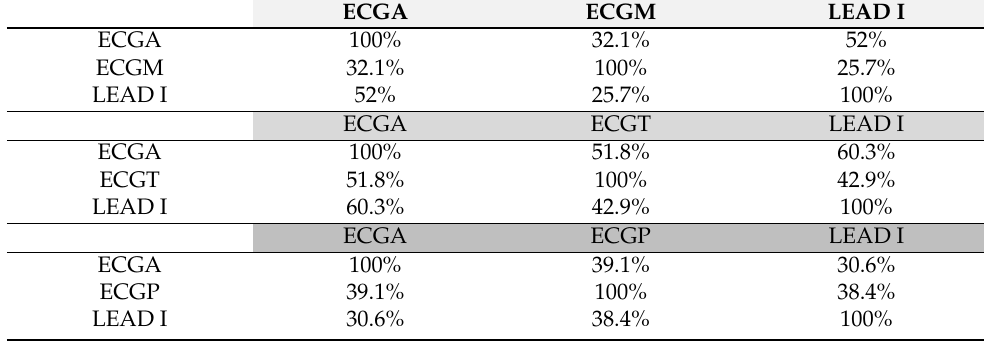
Table 3. Rate correlation in (%) between ECG signals measured in different auscultation